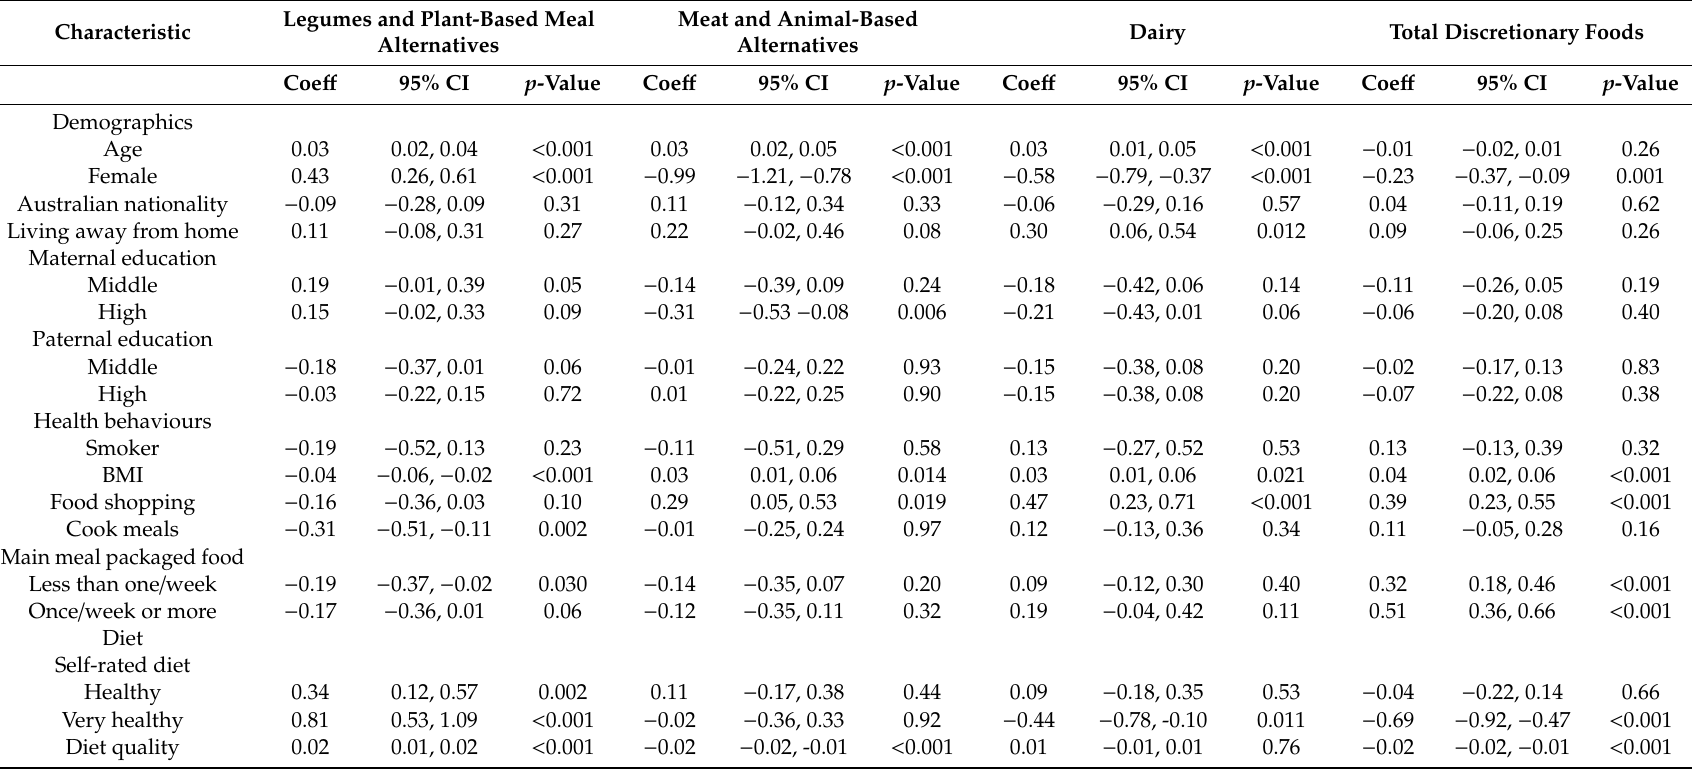
Table 4. Multiple linear regression analysis for the association of liking core foods and total discretionary foods with demographics, health behaviours, diet quality and anthropometrics in young Australian adults ( n =